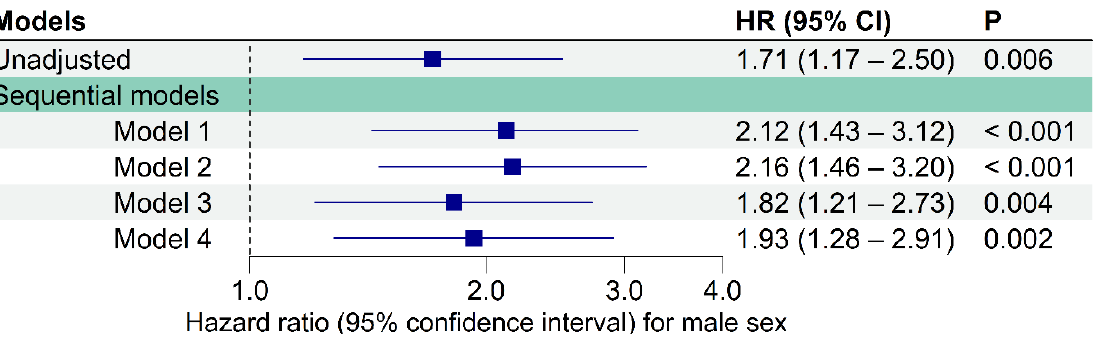
Figure 3. Unadjusted and adjusted hazard ratios for male sex in sequential multivariate Cox pro- portional hazards analyses of long-term mortality after surgical aortic valve replacement. The navy boxes in the plot indicate the hazard ratio of each model. Model 1: adjusted for age, BMI, and the EuroSCORE II as well as male sex. Model 2: adjusted for aortic valve cusp number (tricuspid aortic valve vs. non-tricuspid aortic valve) and Model 1. Model 3: adjusted for preoperative comorbidities (i.e., diabetes mellitus type 2 on insulin, coronary artery disease, congestive heart failure, cerebral vascular disease, chronic kidney disease, and chronic obstructive pulmonary disease) and Model 2. Model 4: adjusted for calcium channel blocker medications and Model 3. SAVR, surgical aortic valve replacement; HR, hazard ratio; CI, confidence interval; BMI, body mass index; EuroSCORE II, Eu- ropean system for cardiac operative risk evaluation II.